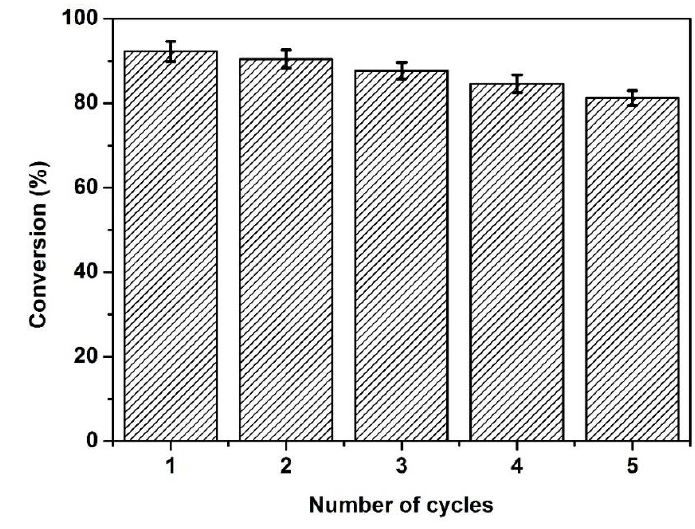
Figure 12. The reuse test results of the immobilized lipase for the transesterification of soybean oil. Reaction conditions as follows: Biocatalyst amount, 25 wt.%; reaction temperature, 40 °C; methanol/oil molar ratio, 4:1; reaction time, 60 h.